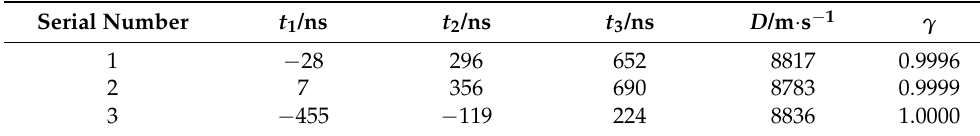
Table 7. Experimental data with L = 3 mm, a = 0.5 mm.